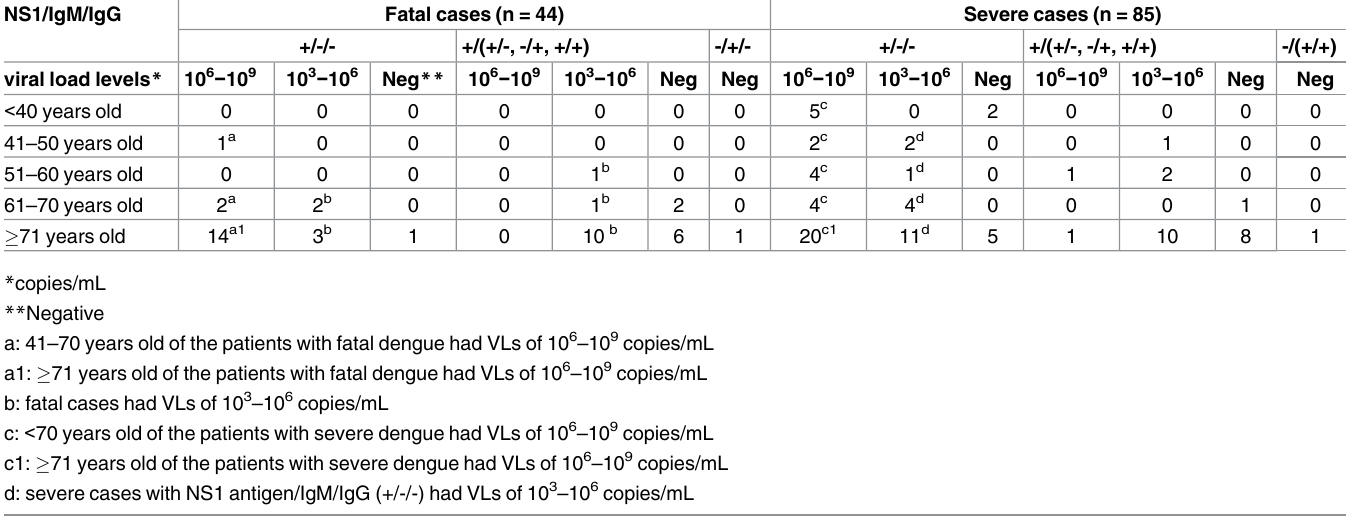
TaqMan assays, as opposed to commercial SYBR and FRET assays. Additionally, the most pop-